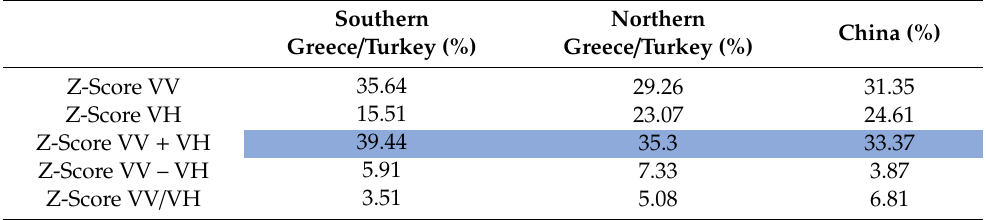
Table 4. Random forest importance analysis of the time series features for TOW and individual study areas. The rows highlighted in blue represent the time series features with the highest contribution